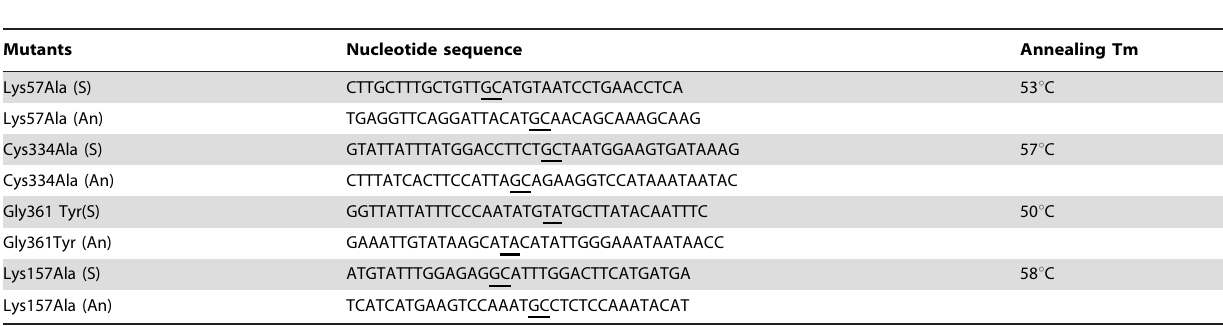
Table 1. Sequence of mutagenic primers and annealing temperature used for PCR amplification of mutant plasmids.